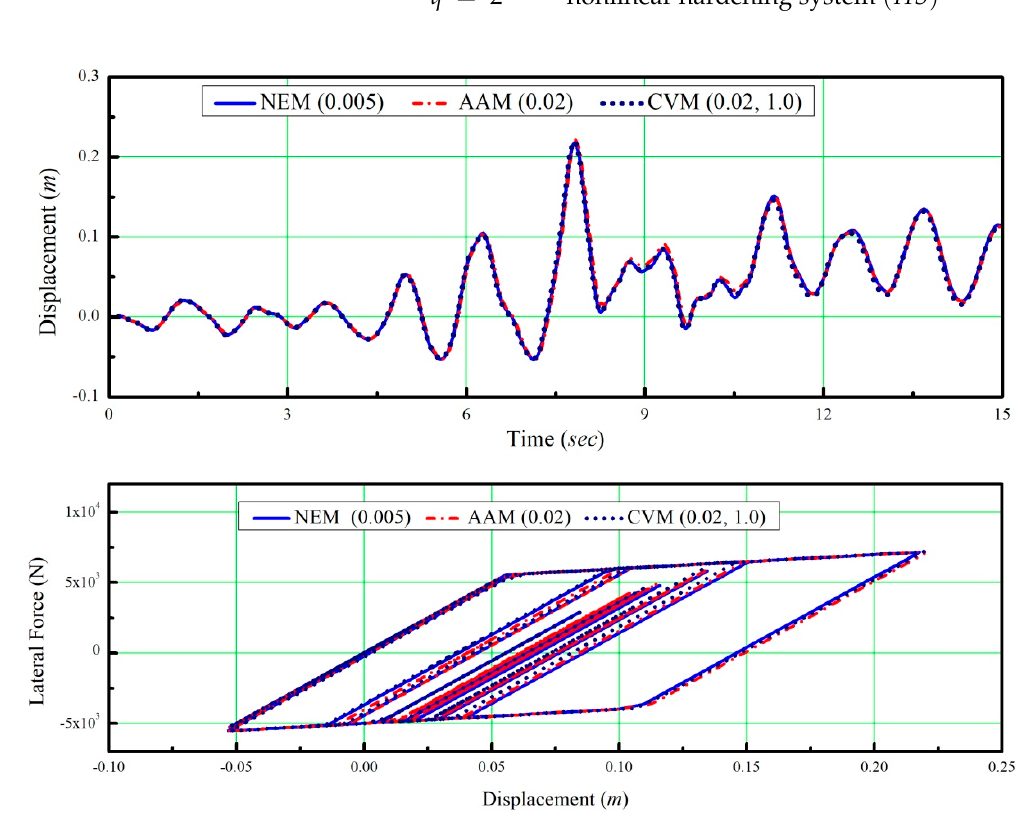
Figure 12. Displacement responses to CHY028 and the corresponding hysteretic loops for =1. 0 ρ .